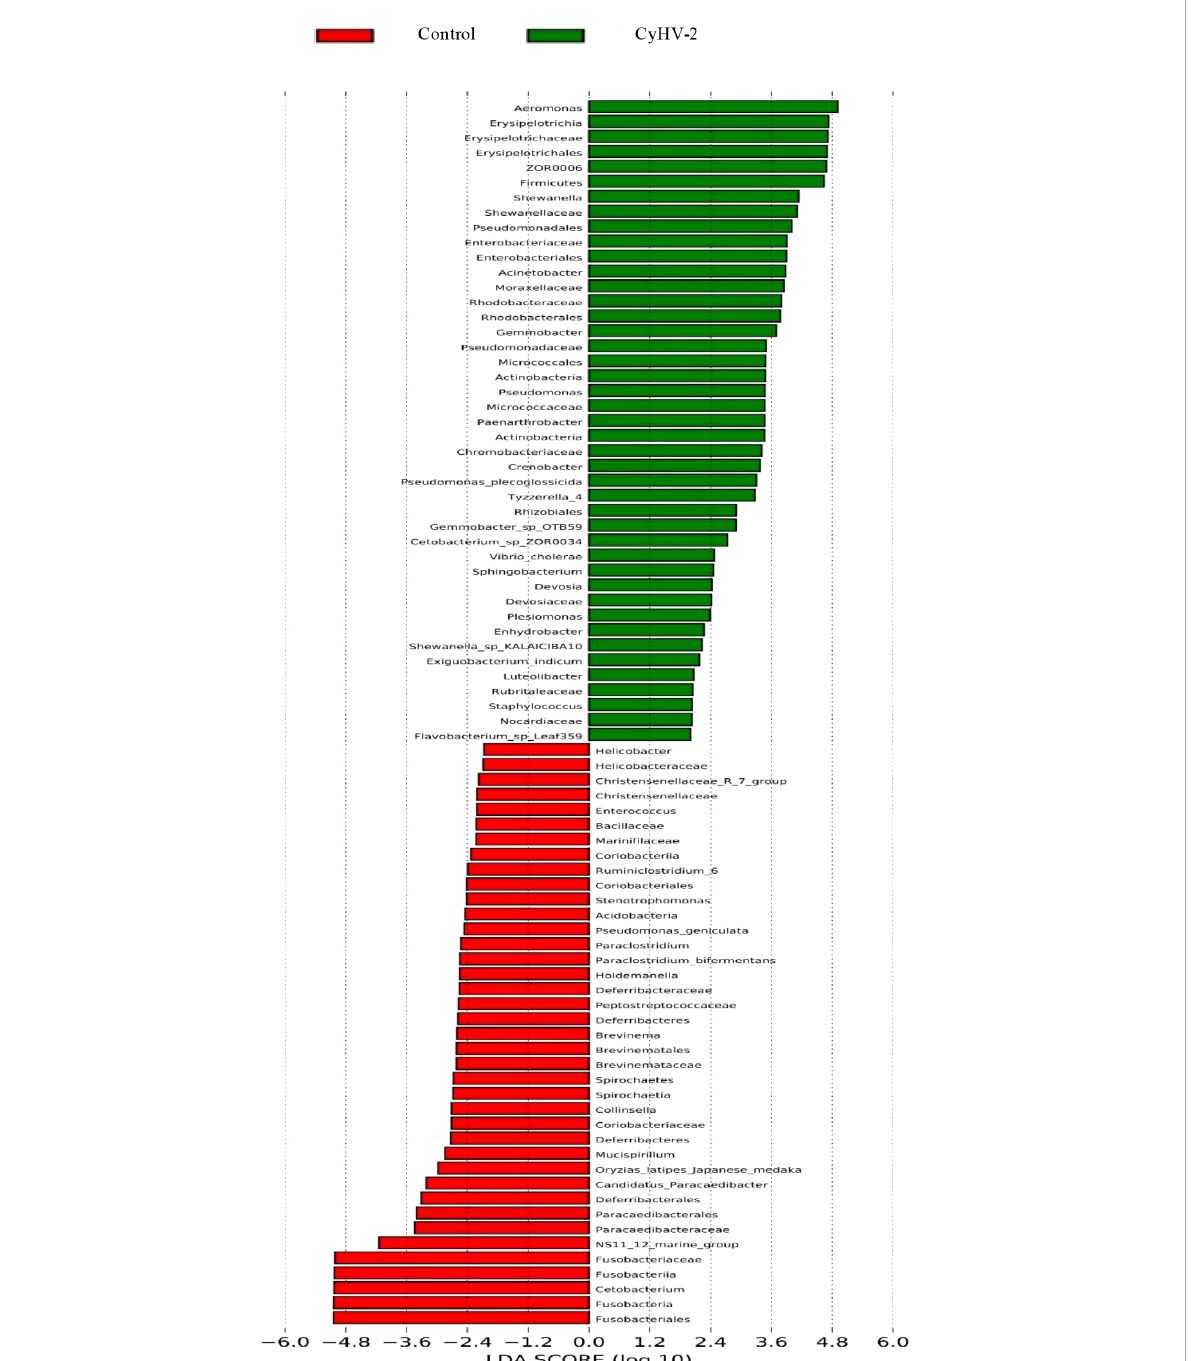
infection group (Figure 3B). A time-dependent abundance of Aeromonas in the midgut of gibel carp post-CyHV-2 infection by the culture method increased from 3.8 × 10 4 CFU g -1 midgut at 0 dpi to 6.4 × 10 5 CFU g -1 midgut at 1 dpi, 2.8 × 10 6 CFU g -1